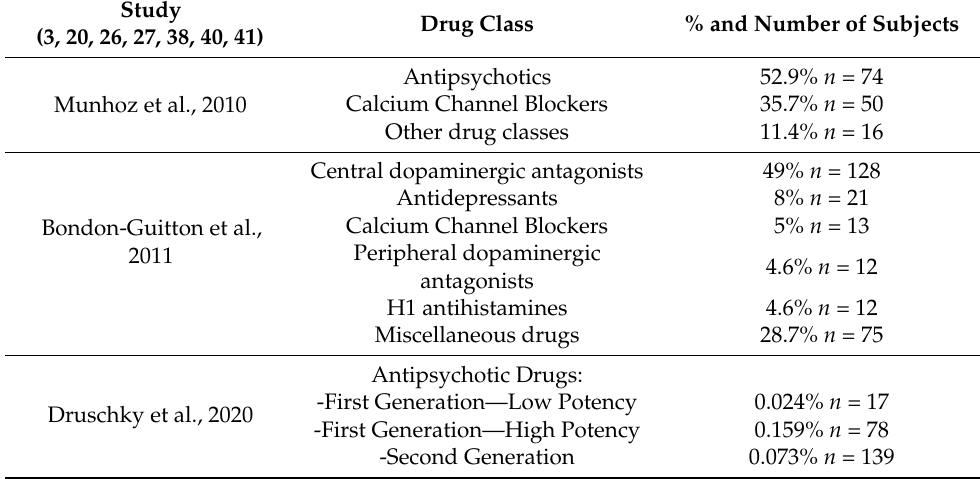
Table 3. Studies highlighting specific drugs associated with Drug-induced Parkinsonism and their